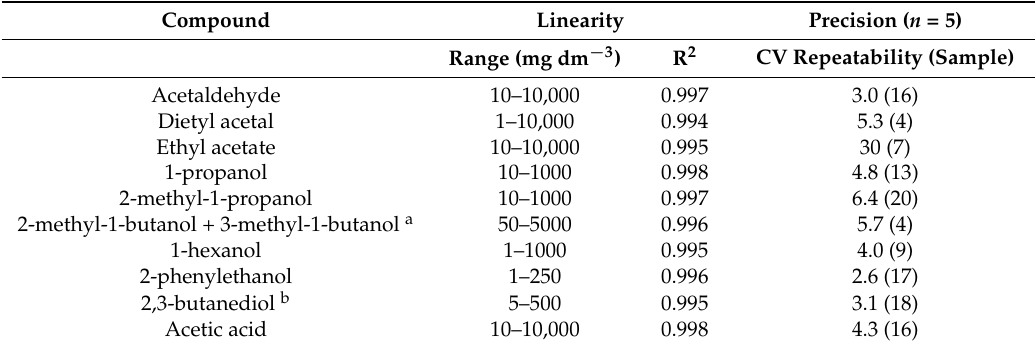
Table 2. Linearity and precision data for the GC-MS determination of volatile compounds in Filuferru